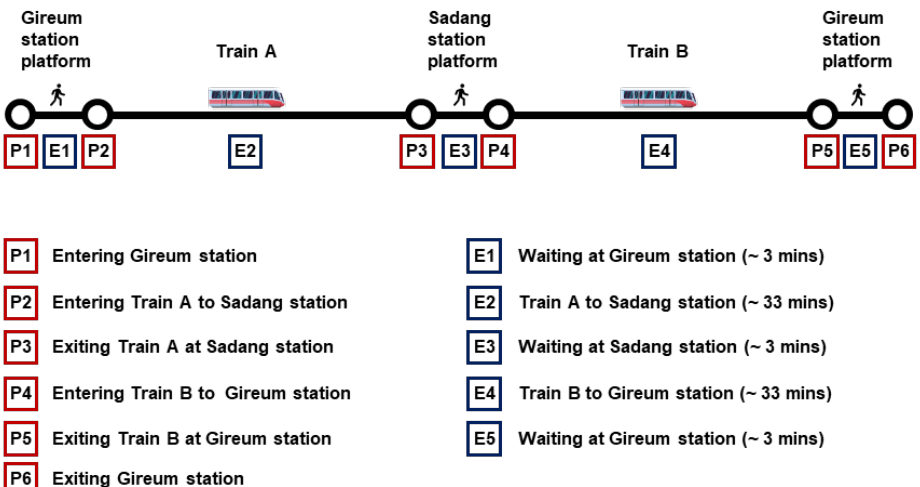
Figure 3. Schematic representation of the naturalistic experiment done, divided into